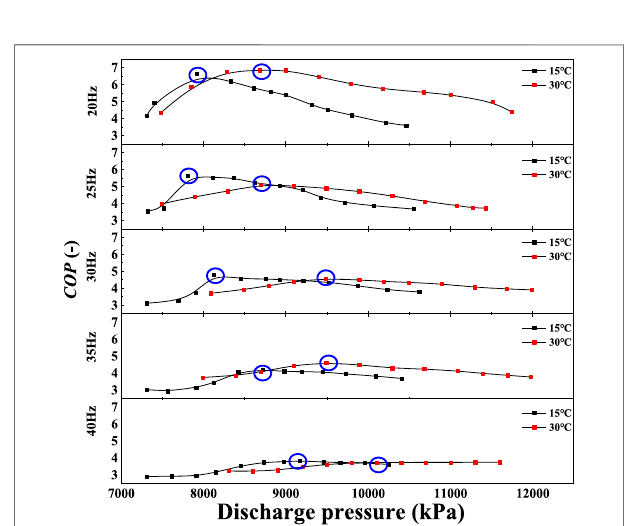
FIGURE 4 | COP at different compressor frequencies and ambient temperatures.